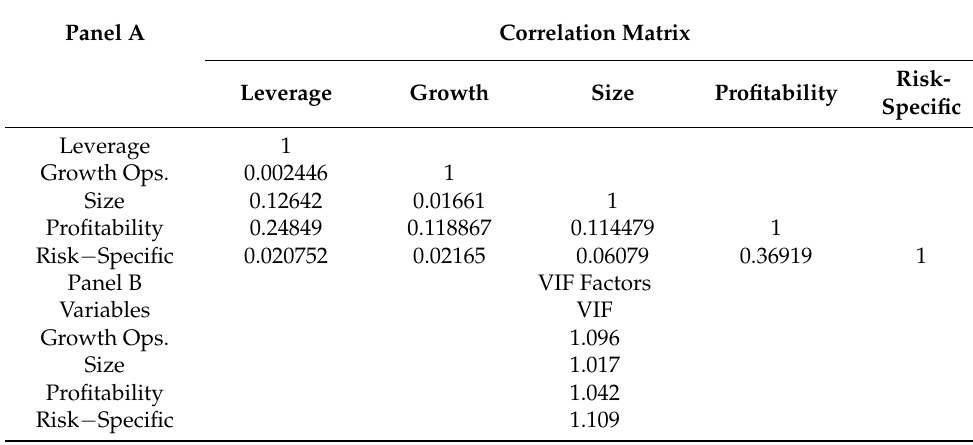
Table 2. Multicollinearity test result among